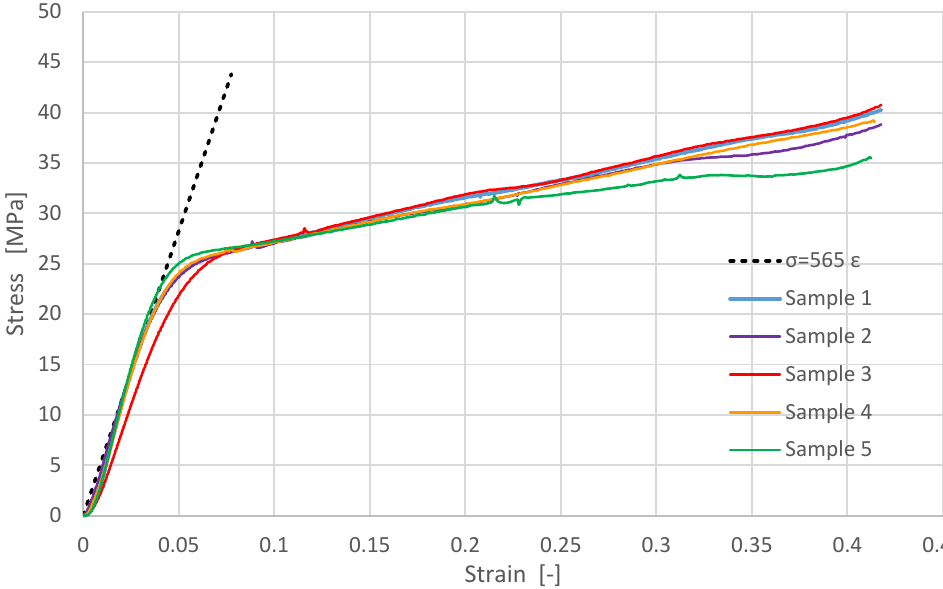
Figure 7. Experimental results for vertically layered printed samples: engineering compressive stress versus compressive strain. The testing results for samples 2–5 show stress peaks for stresses between 26–32 MPa, due to the inhomogeneity of the vertically layered printed samples. Figure 8 shows details from Figure 7 for samples 2–5.